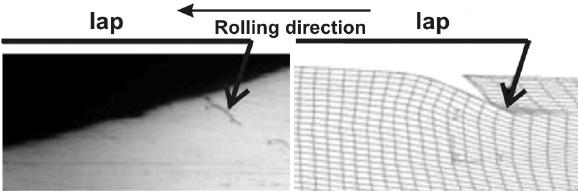
Figure 5. The prediction of V-shaped cracks evolution in continuously cast steel slab.